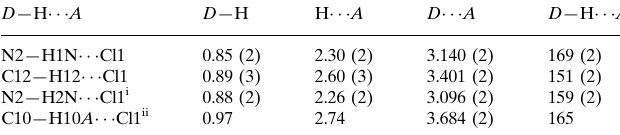
Hydrogen-bond geometry (A˚ , (cid:3) ).